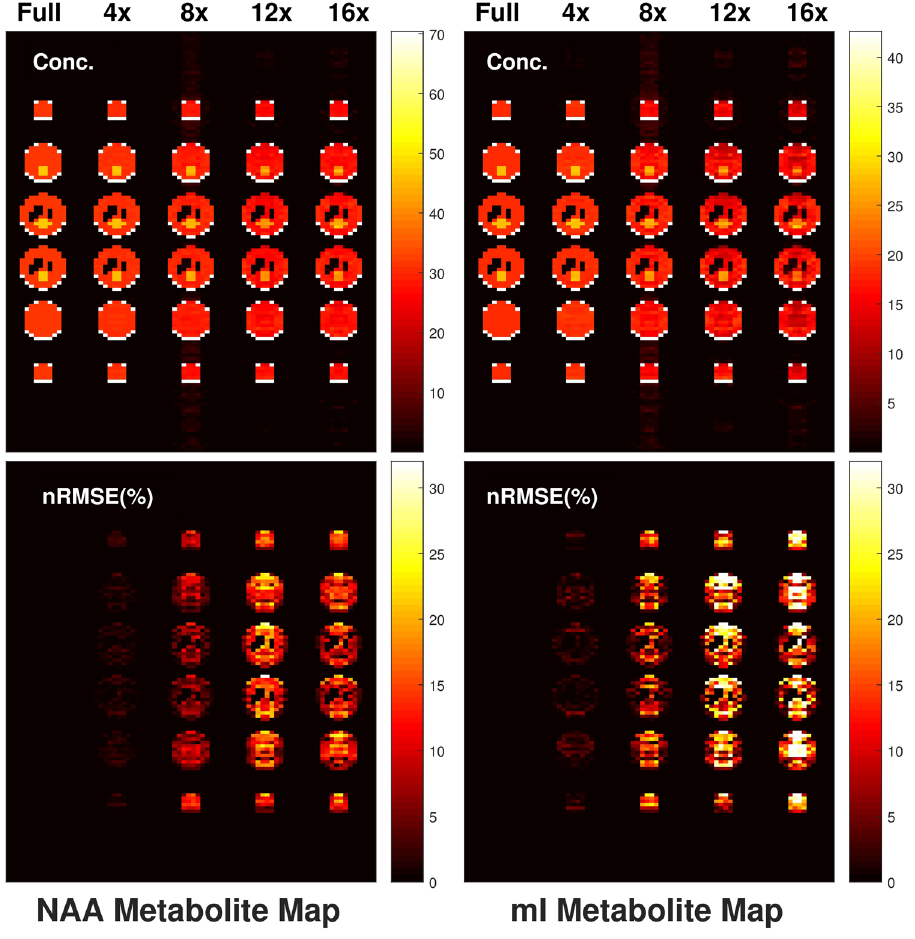
Figure 2. Metabolite maps are displayed for NAA (left) and mI (right). Concentration maps (top) as well as nRMSE maps (bottom) demonstrate the overall depreciation of accuracy as fewer points are sampled before reconstruction. Higher error is prevalent in the central part of the phantom when compared to the left and right edges. At 8x, NAA had a spatial nRMSE% value of 7%, whereas mI had a spatial nRMSE% value of 11%.